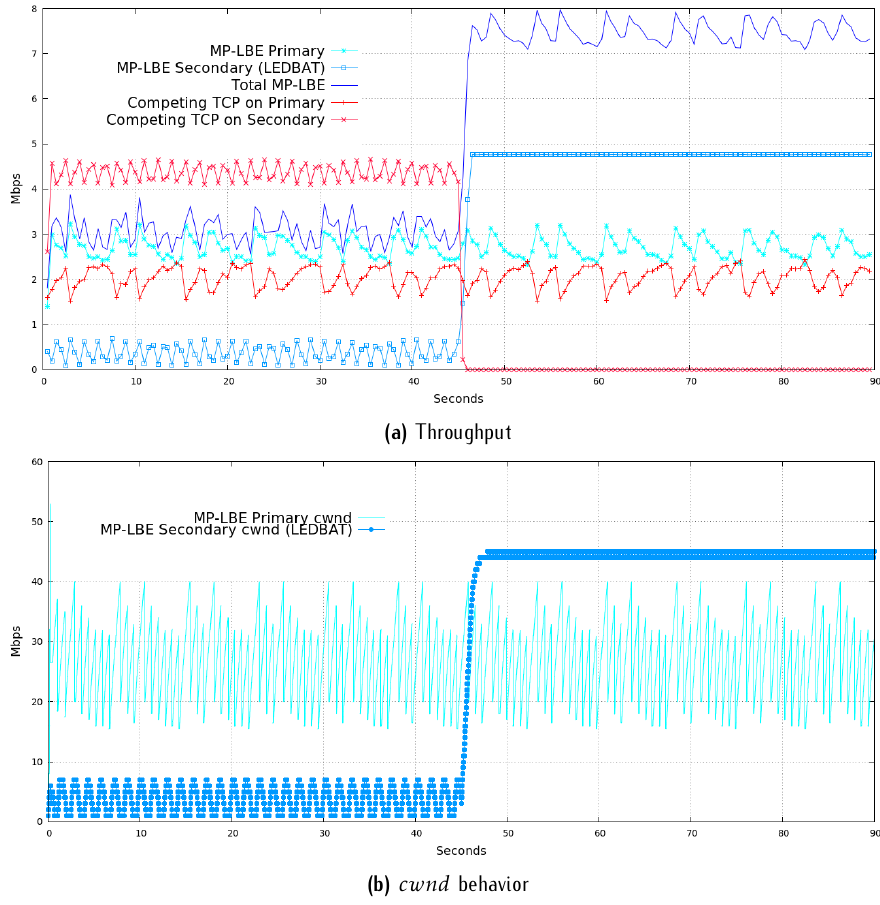
Figure 3. Bandwidth scavenging behavior of MP-LBE using